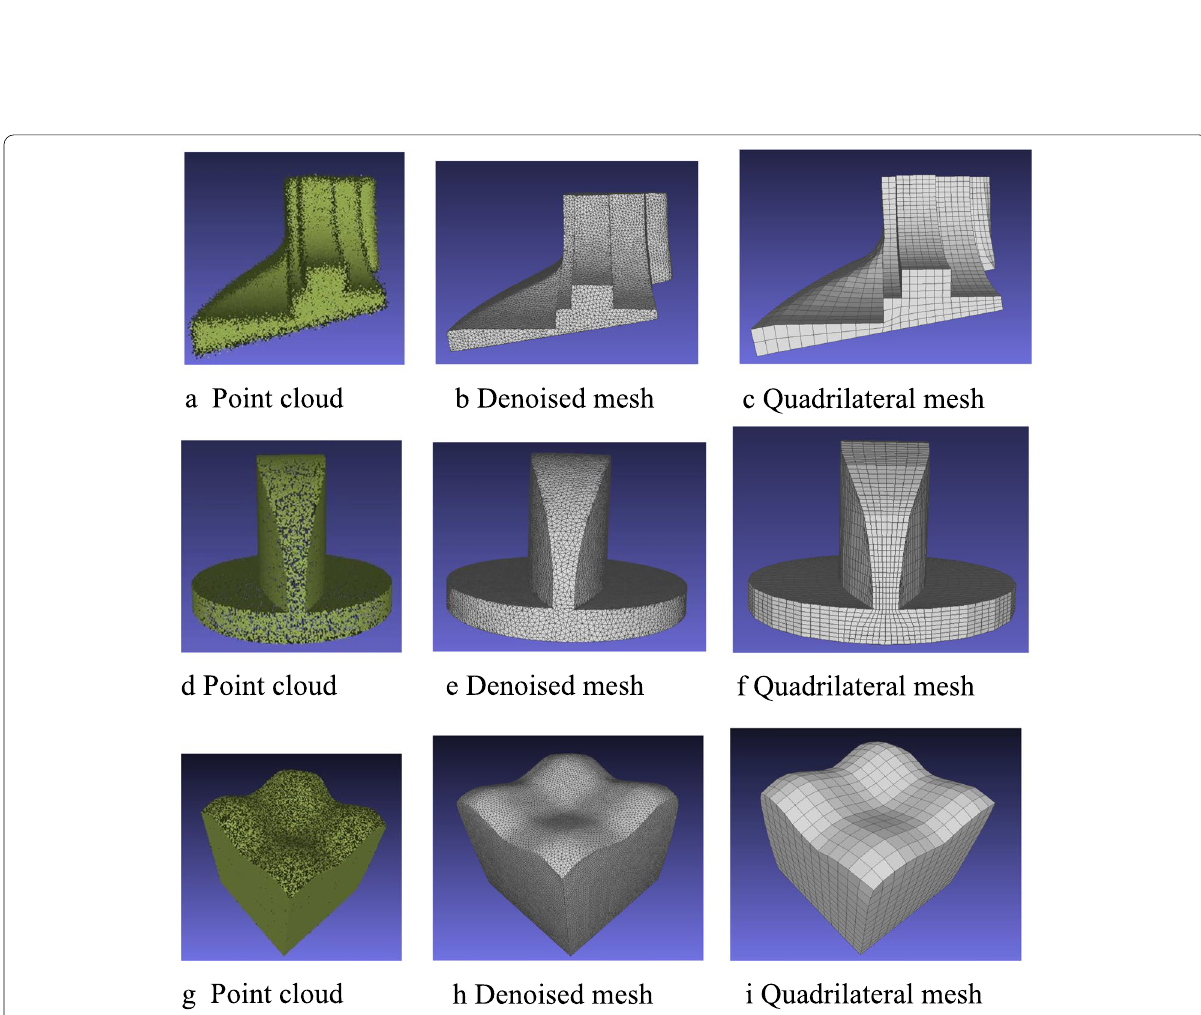
Fig. 17 From point cloud to mesh: a ‑ c Fandisk models; d ‑ f Spheredisk models; g ‑ i Surfcube